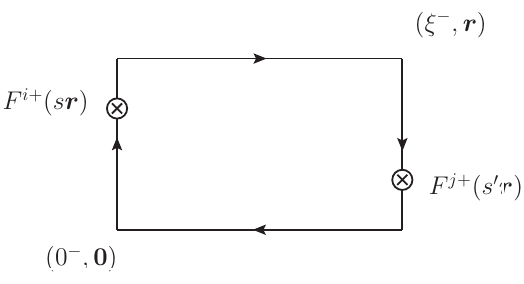
Figure 1: Diagrammatic depiction of the nonlocal operator that defines the uninte- grated gluon distribution in Eq. (1). The horizontal and vertical lines represent path ordered Wilson lines along the + and transverse directions,